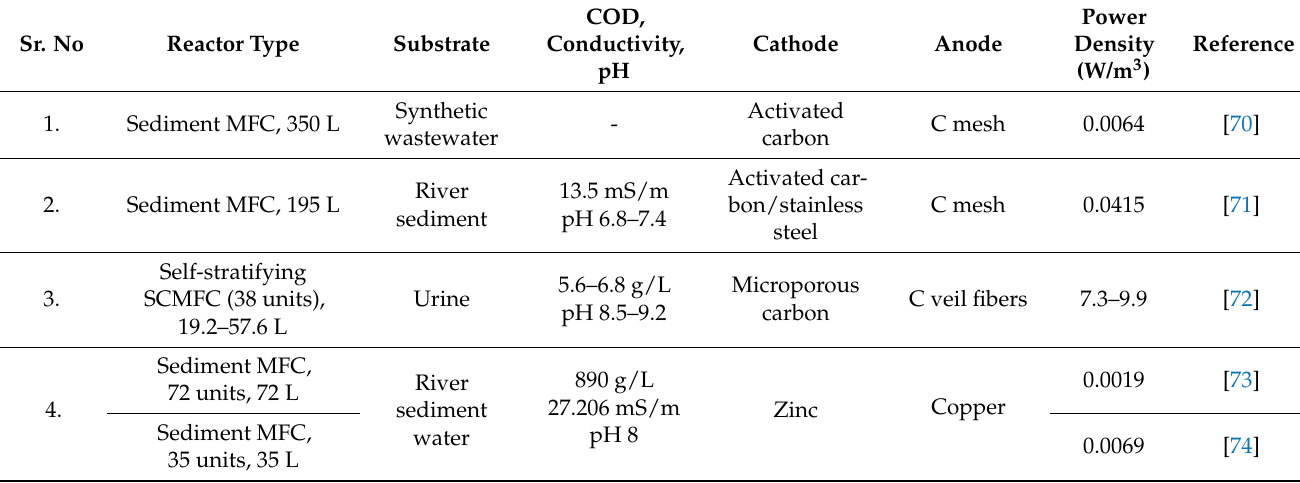
Table 2. Several studies demonstrating the performance of sediment